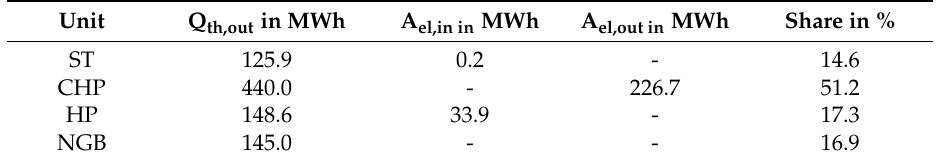
Table 1. Results of a simulation for the operation of the local heating network under standard control.